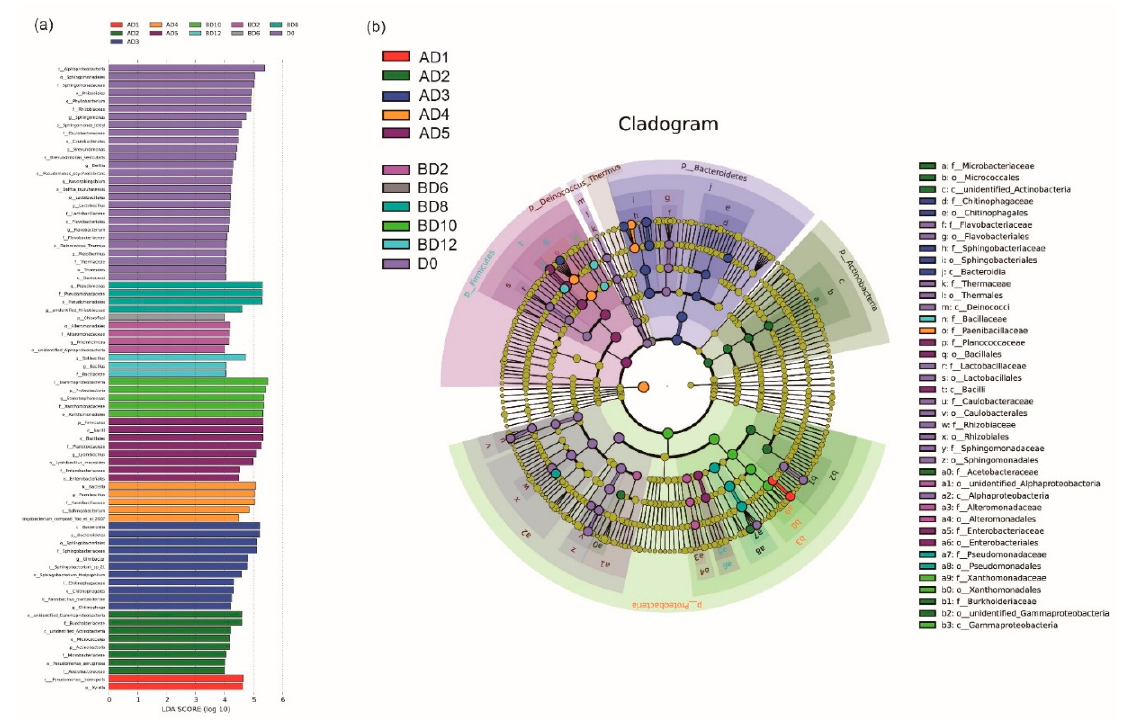
Figure 5. The ( a ) LDA (linear discriminant analysis) value distribution histogram and ( b ) evolutionary branch map. Description: The LDA value distribution histogram shows the species with an LDA scores greater than the set value (the default setting is 4), i.e., the biomarkers with statistical di ff erences among the groups. Species with abundant significant di ff erences among di ff erent groups are shown, and the length of the histogram represents the magnitude of the impact of di ff erent species (i.e., the LDA score). In the evolutionary branch diagram, the circle radiating from the inside to the outside represents the classification level from the Phylum to the Genus (or Species ). Each small circle at a di ff erent classification level represents a classification at that level, and the diameter of the small circle is proportional to the relative abundance. Color scheme: species without significant di ff erences are uniformly colored yellow; the di ff erential species biomarkers are colored by group. The red nodes represent the microbial groups that play important roles in the red group, and the green nodes indicate microbial groups that play important roles in the green group. If a group is missing in the figure, there was no significant di ff erences in that group. The species name represented by letters in the figure are shown in the legend on the right.